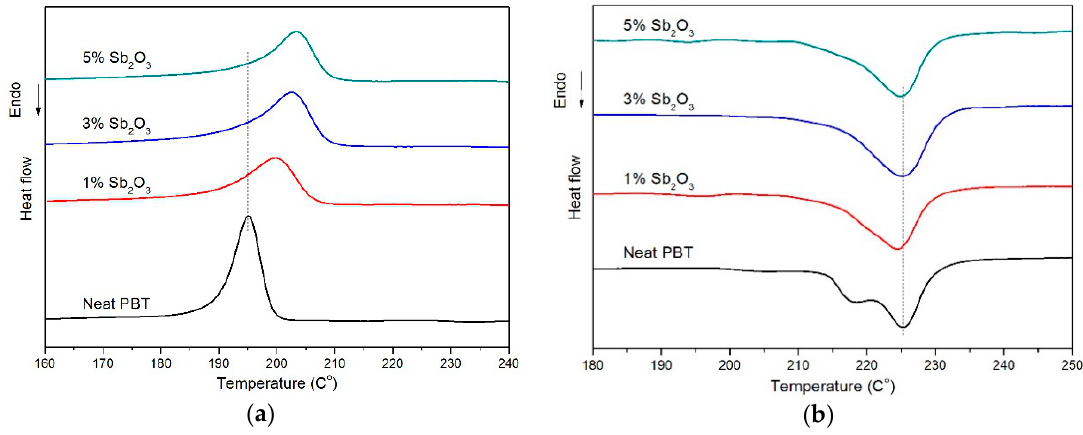
Figure 1. DSC non-isothermal crystallization curves ( a ) and melting curves ( b ) of neat poly(butylene terephthalate) (PBT) and its nanocomposites.